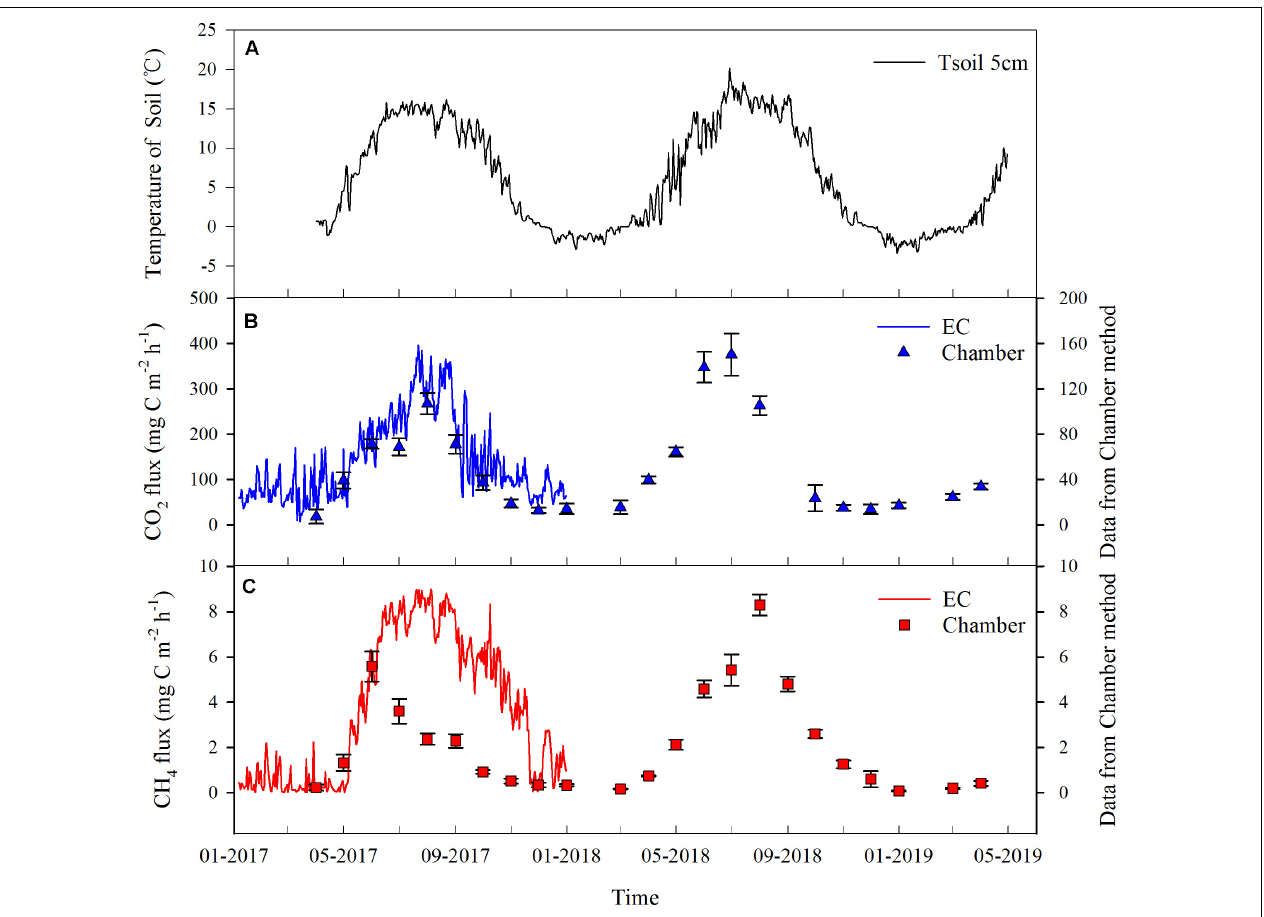
FIGURE 2 | Variations in soil temperature and CO 2 and CH 4 fluxes of the wetland site during the measurement period. Daily mean values of (A) soil temperature at 5 cm below ground from April 2017 to April 2019, (B) CO 2 flux rates, and (C) CH 4 flux rates. Solid blue and red lines indicate data obtained using the eddy covariance (EC) method from January to December 2017. The blue triangles and red squares indicate data collected using the chamber method from April 2017 to April 2019. Standard error is represented by vertical lines on triangles and